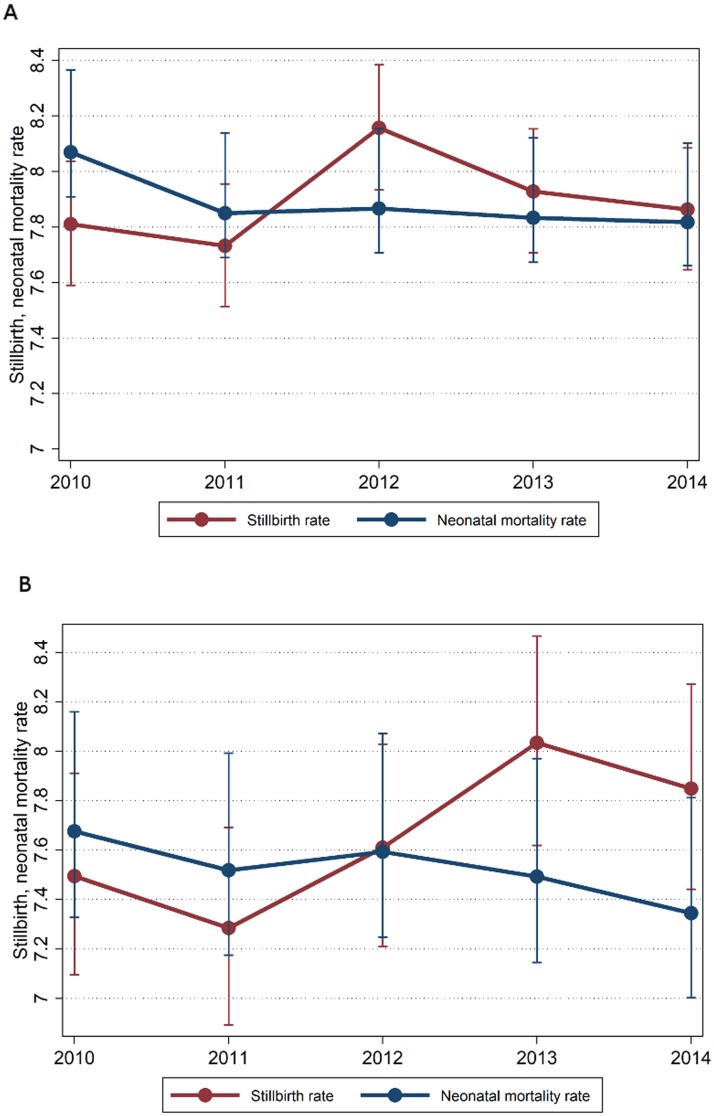
Trends in stillbirth and neonatal mortality rates (per 1000 births, with 95% confidence intervals) from 2010 to 2014 within (A) the entirety of São Paulo (SP) state and (B) São Paulo municipality only.